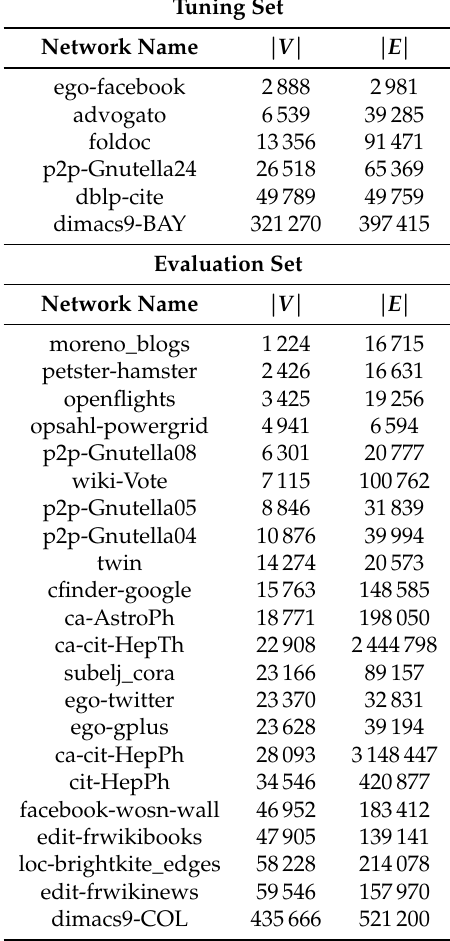
Table 3. Instances are split into tuning and evaluation